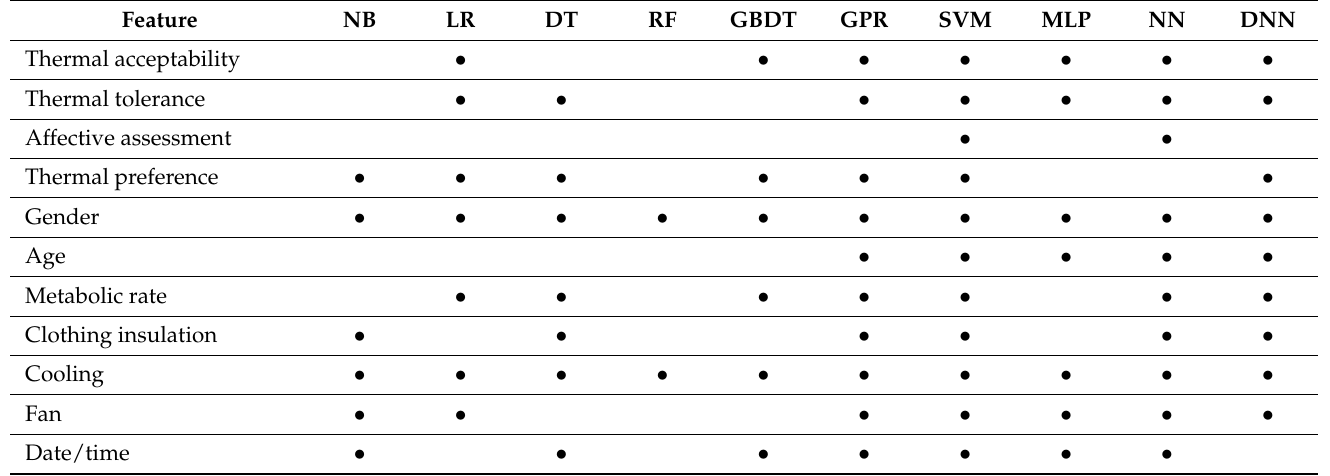
Table 10 compares the machine learning models based on analysis using feature